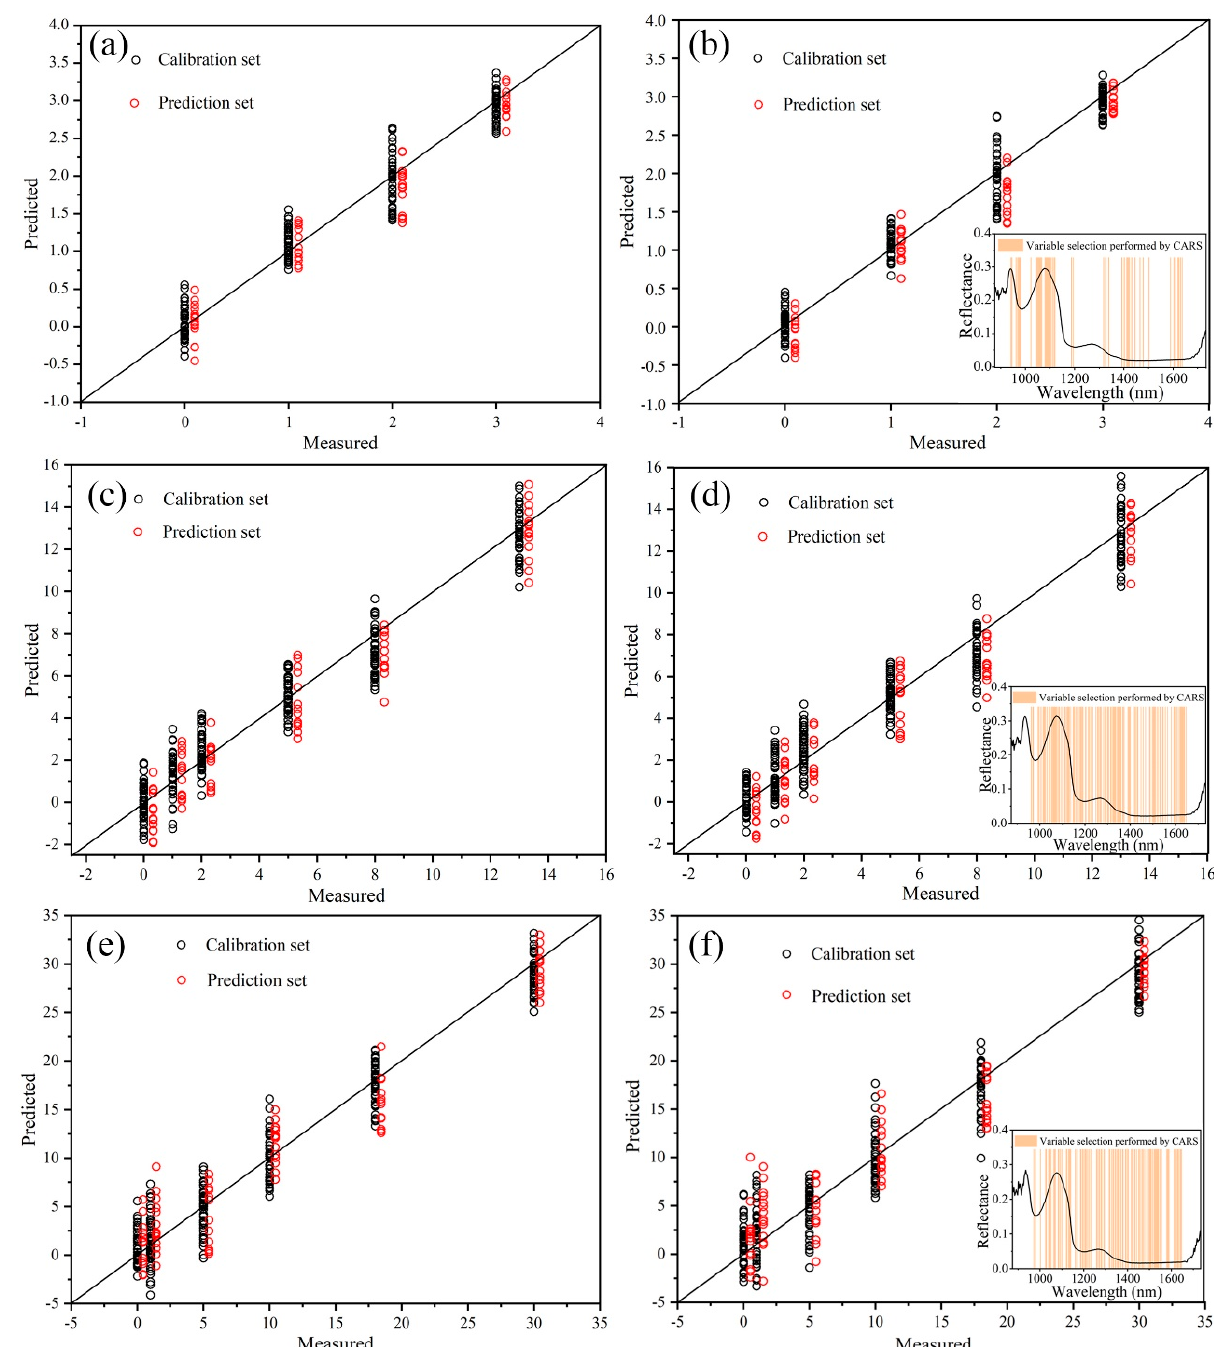
Figure 4. PLS regression (PLSR) and competitive adaptive reweighted sampling-PLSR (CARS-PLSR) models of storage time under different storage conditions: ( a , b ): Room temperature; ( c , d ) refrigeration; ( e , f )